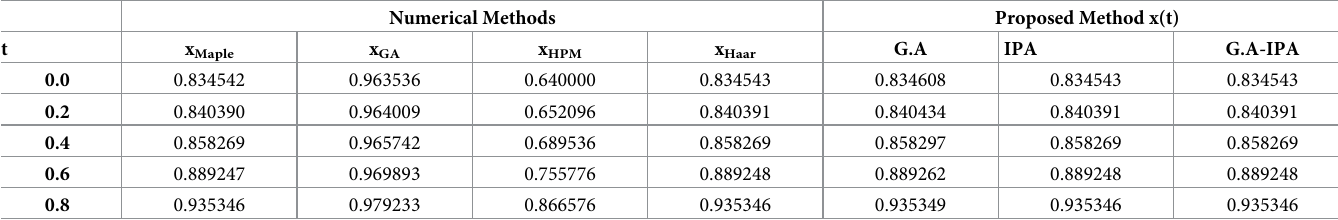
Table 14. Approximate solutions by numerical methods and proposed method for δ = 0.6.